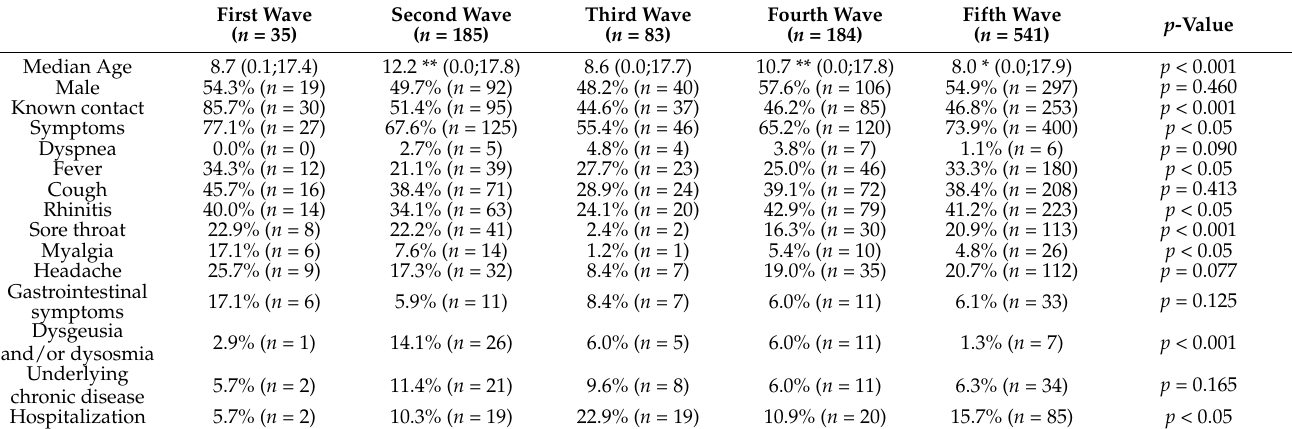
Table 3. Tests positive for SARS-CoV-2 throughout the five waves ( n = 1028); * = p < 0.05, ** = p < 0.001.